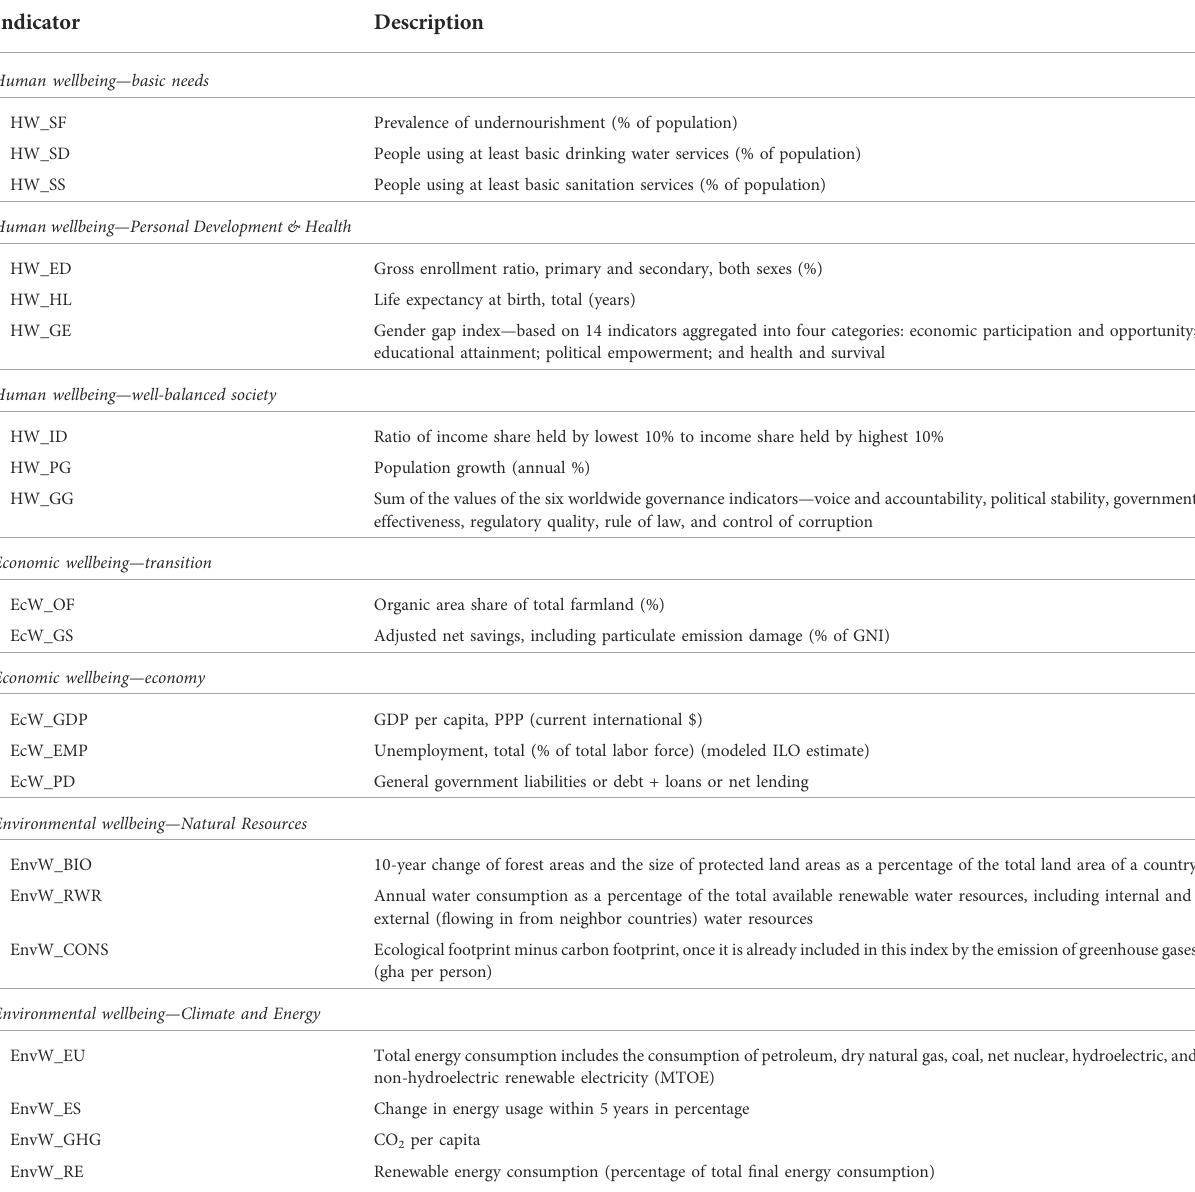
TABLE 1 Description of SSI